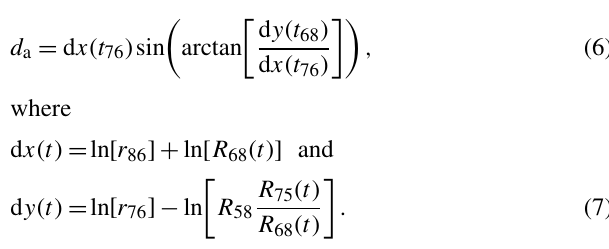
Figure 7. Four superimposed kernel density estimates (KDEs, us- ing a 50Myr bandwidth) for 70869 unfiltered zircon U–Pb dates. The 207 Pb / 235 U, 206 Pb / 238 U, and concordia age spectra are sim- ilar. However the KDE of the 207 Pb / 206 Pb data stands apart from the other three curves. It deviates both at the young end of the age spectrum (which it suppresses) and at the old end (which it